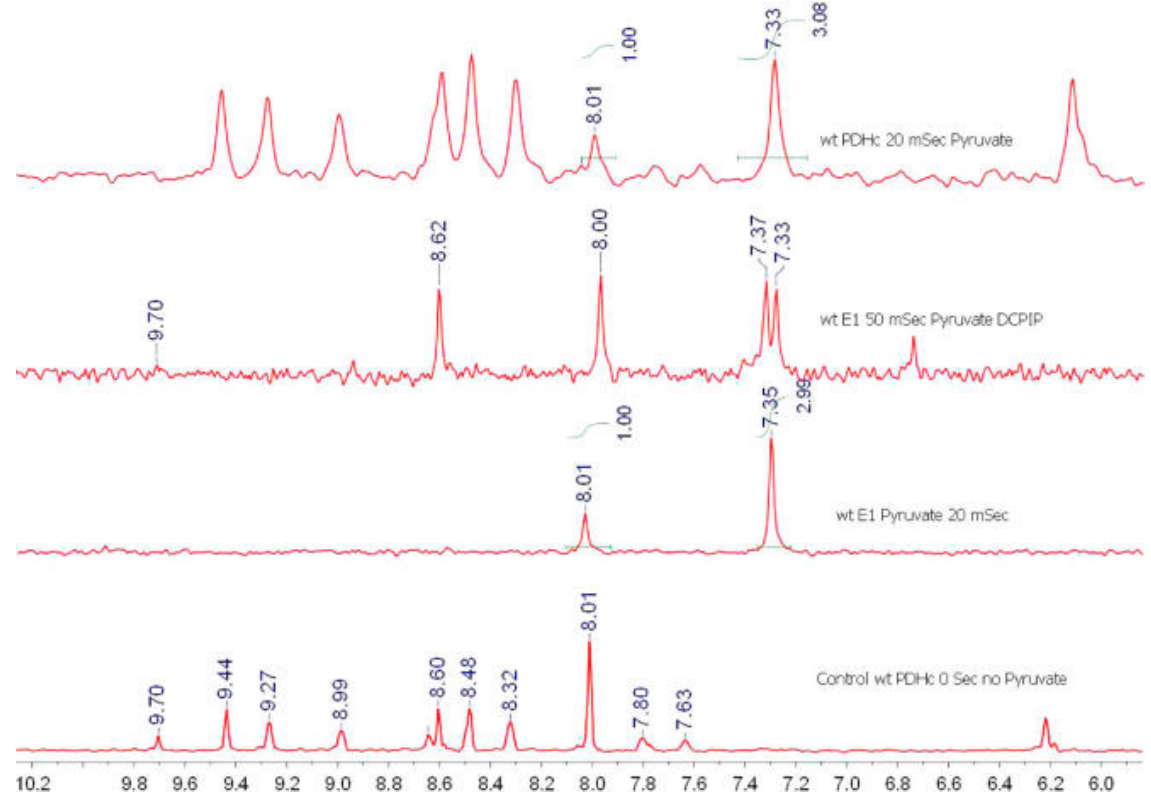
Figure 2. Distribution of ThDP-bound covalent intermediates in reactions of the E. coli E1p component and in the intact PDHc complex [55]. gCHSQC NMR spectra of the supernatant after acid quench of PDHc and removal of protein from the reaction. Top spectrum; 20 ms quench of the reaction of PDHc; Second spectrum from top: 50 ms quench of the reaction of E1p with pyruvate and DCPIP; Third spectrum from top: 20 ms quench of the reaction of E1 with pyruvate; Bottom spectrum: control, PDHc reaction mixture quenched before addition of pyruvate. ThDP-derived peaks are marked at 9.71 ppm (C2 − H), 8.62 ppm (AcThDP), 8.01 ppm (C6 ′− H), 7.37 ppm (AcThDP), and 7.34 ppm (HEThDP). Other peaks are due to NAD + , CoA, DCPIP, NADH, acetyl-CoA, or DCPIPH